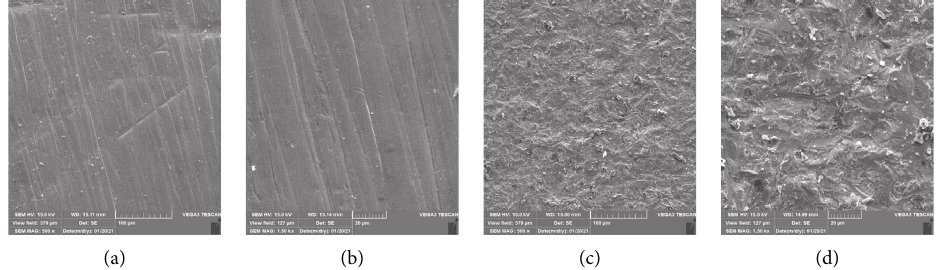
Figure 4: Low-translucent zirconia SEM micrographs: (a, b) without APA and (c, d) with APA ( × 500 and × 1500 magnifications).